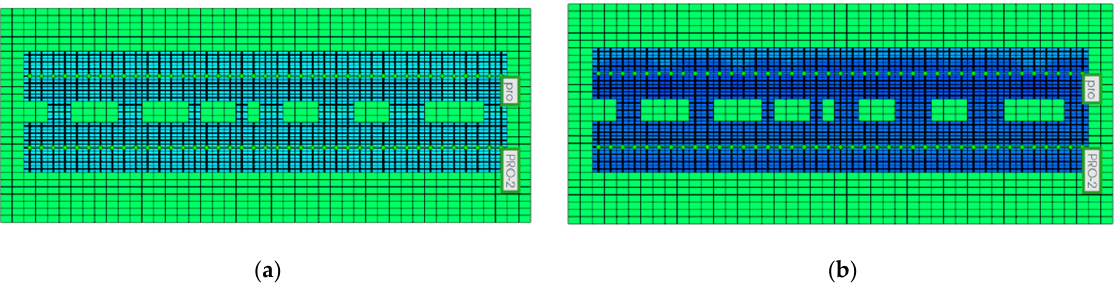
Figure 13. Water saturation distribution after production recovery. ( a ) The reservoir energy level is high. ( b ) The reservoir energy level is low.